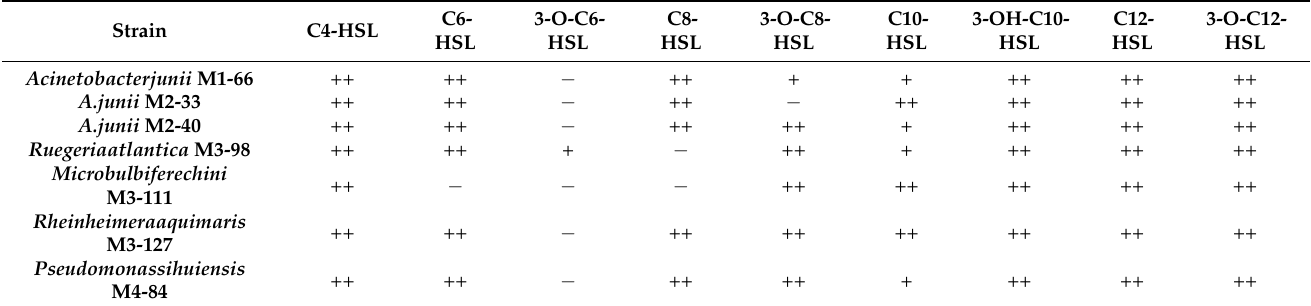
Table 1. Quorum quenching activity of marine strains against synthetic